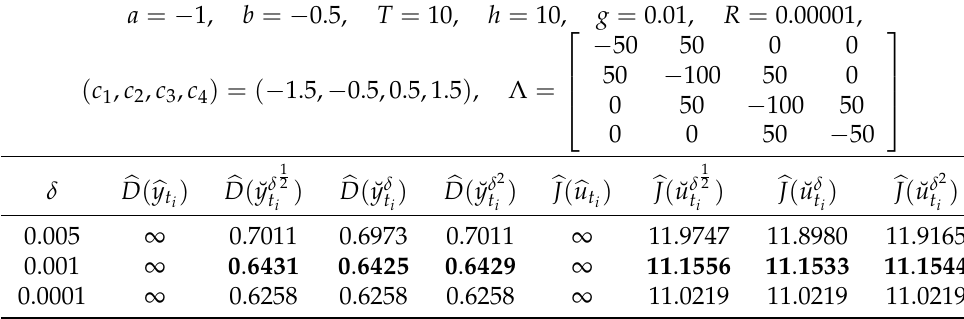
Table 7. The results with the CTMC dimensionality 4 and transition intensities 50.